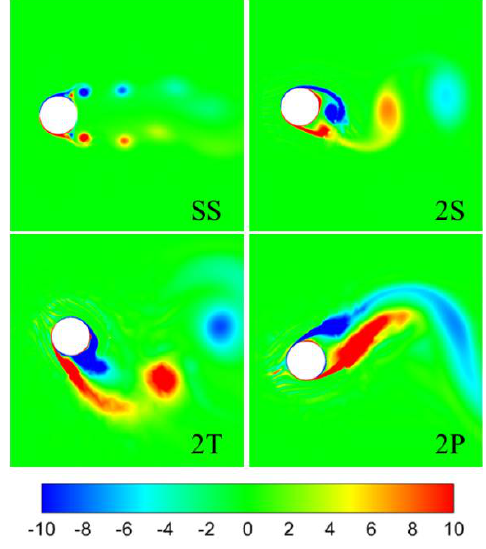
Figure 12. Four typical vortex shedding modes.